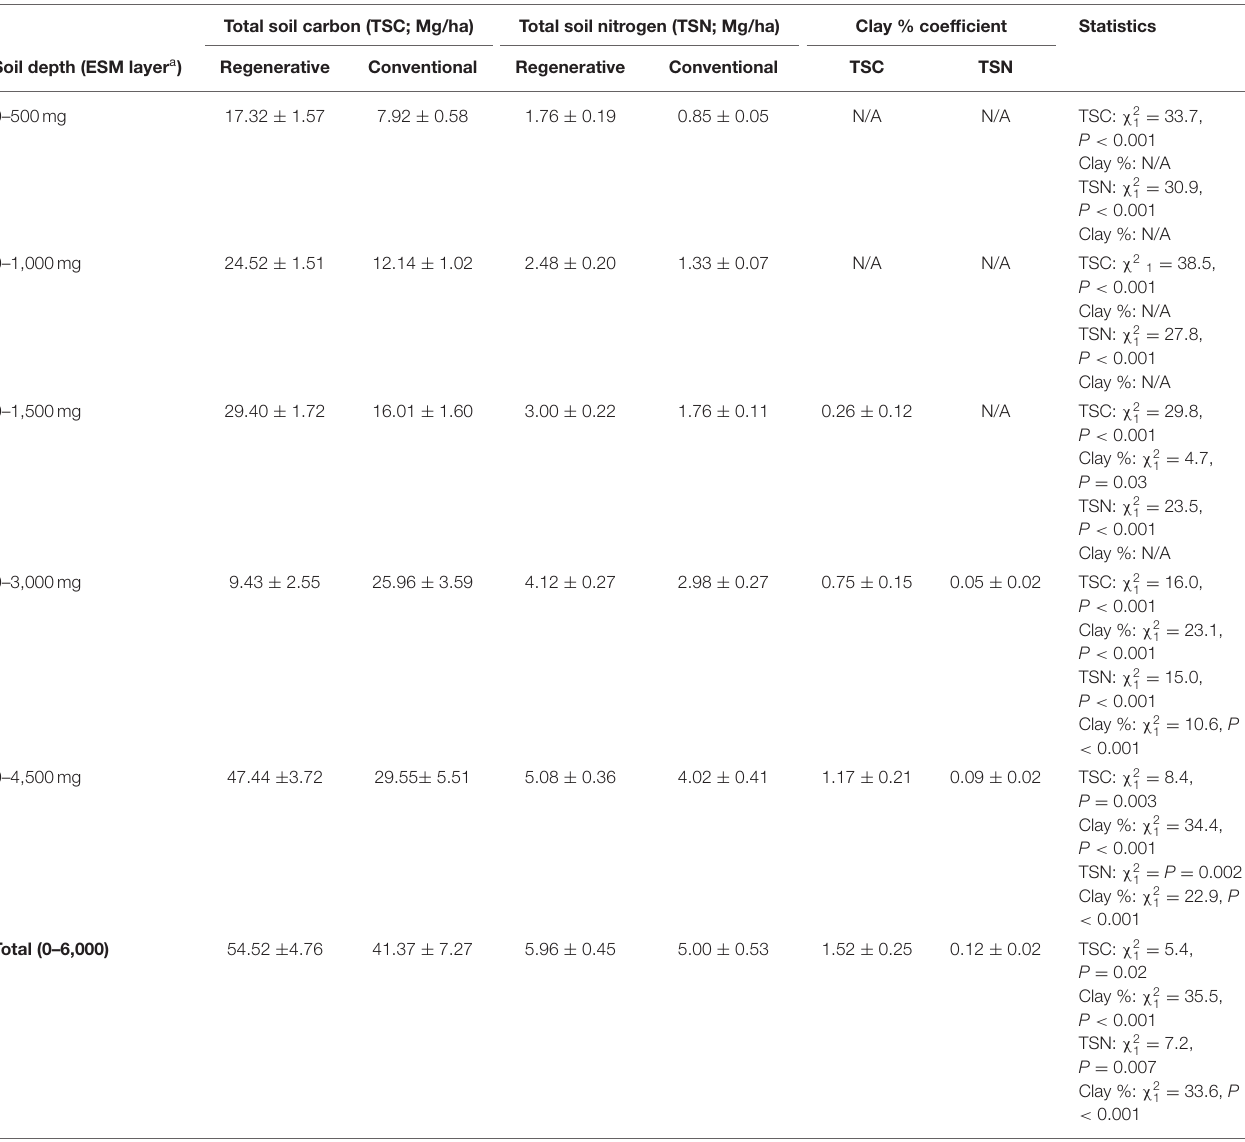
TABLE 3 | The differences in carbon and nitrogen at different soil depths in regenerative and conventional almond